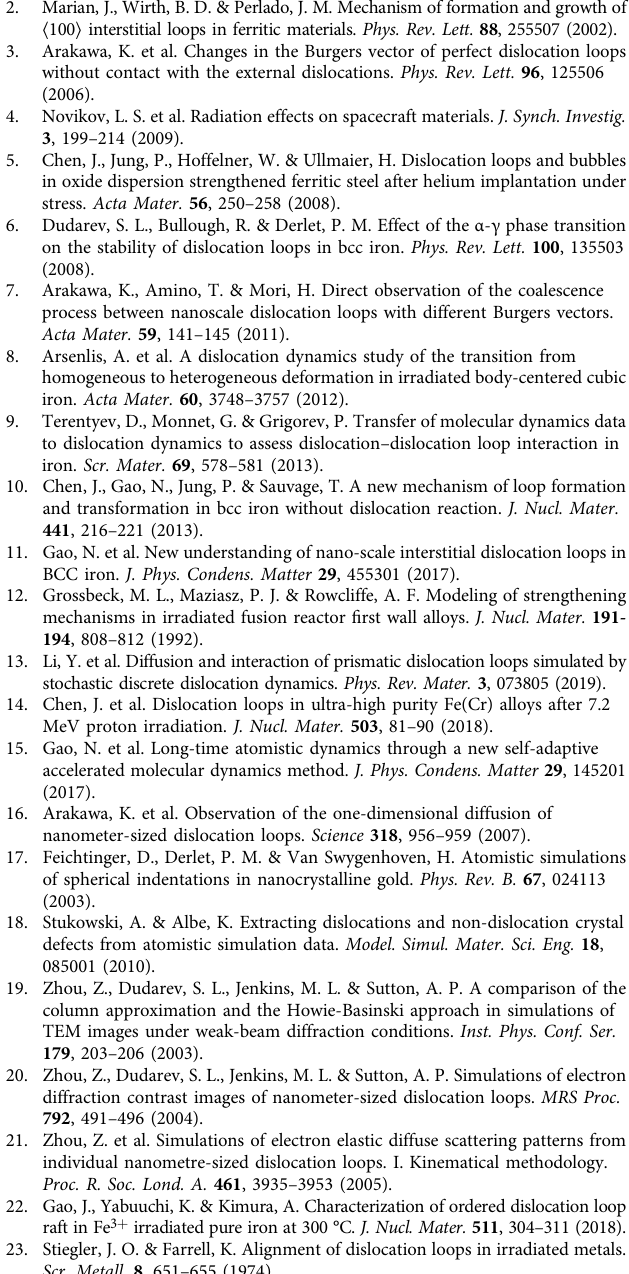
Fig. 8 Schematic of the cylindrical active volume (AV) selected for SAAMD simulations. r and R are radius of the <100> loop and